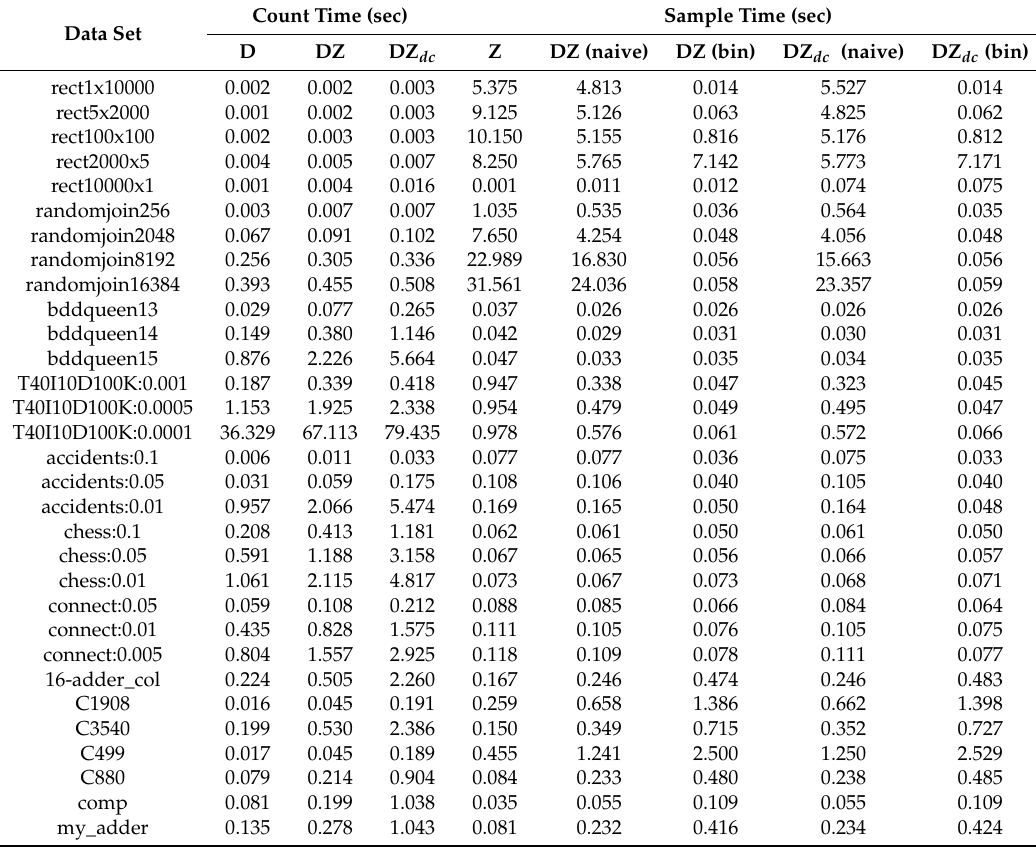
Table 6. Counting time and random sampling